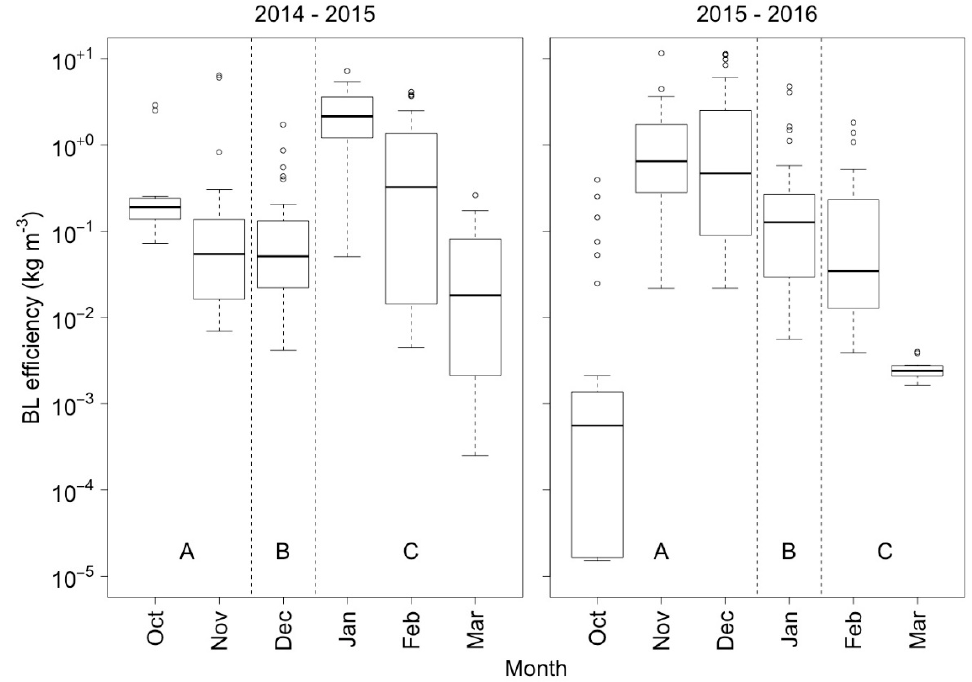
Figure 11. Bedload transport efficiency grouped by month in the two ablation seasons. The main origin of runoff is split in snowmelt ( A ), snow and glacier melting ( B ) and glacier melting ( C ).